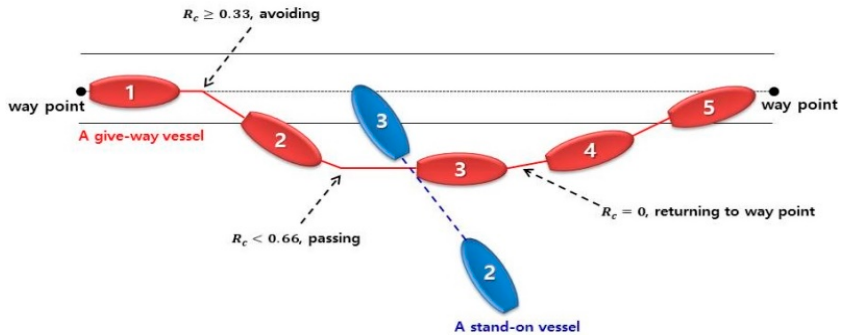
Figure 9. Procedure of collision avoidance according to the R c .